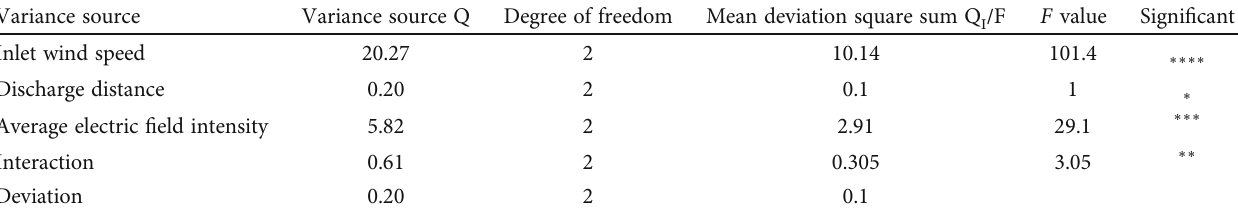
Table 2: Signi fi cant analysis of in fl uencing